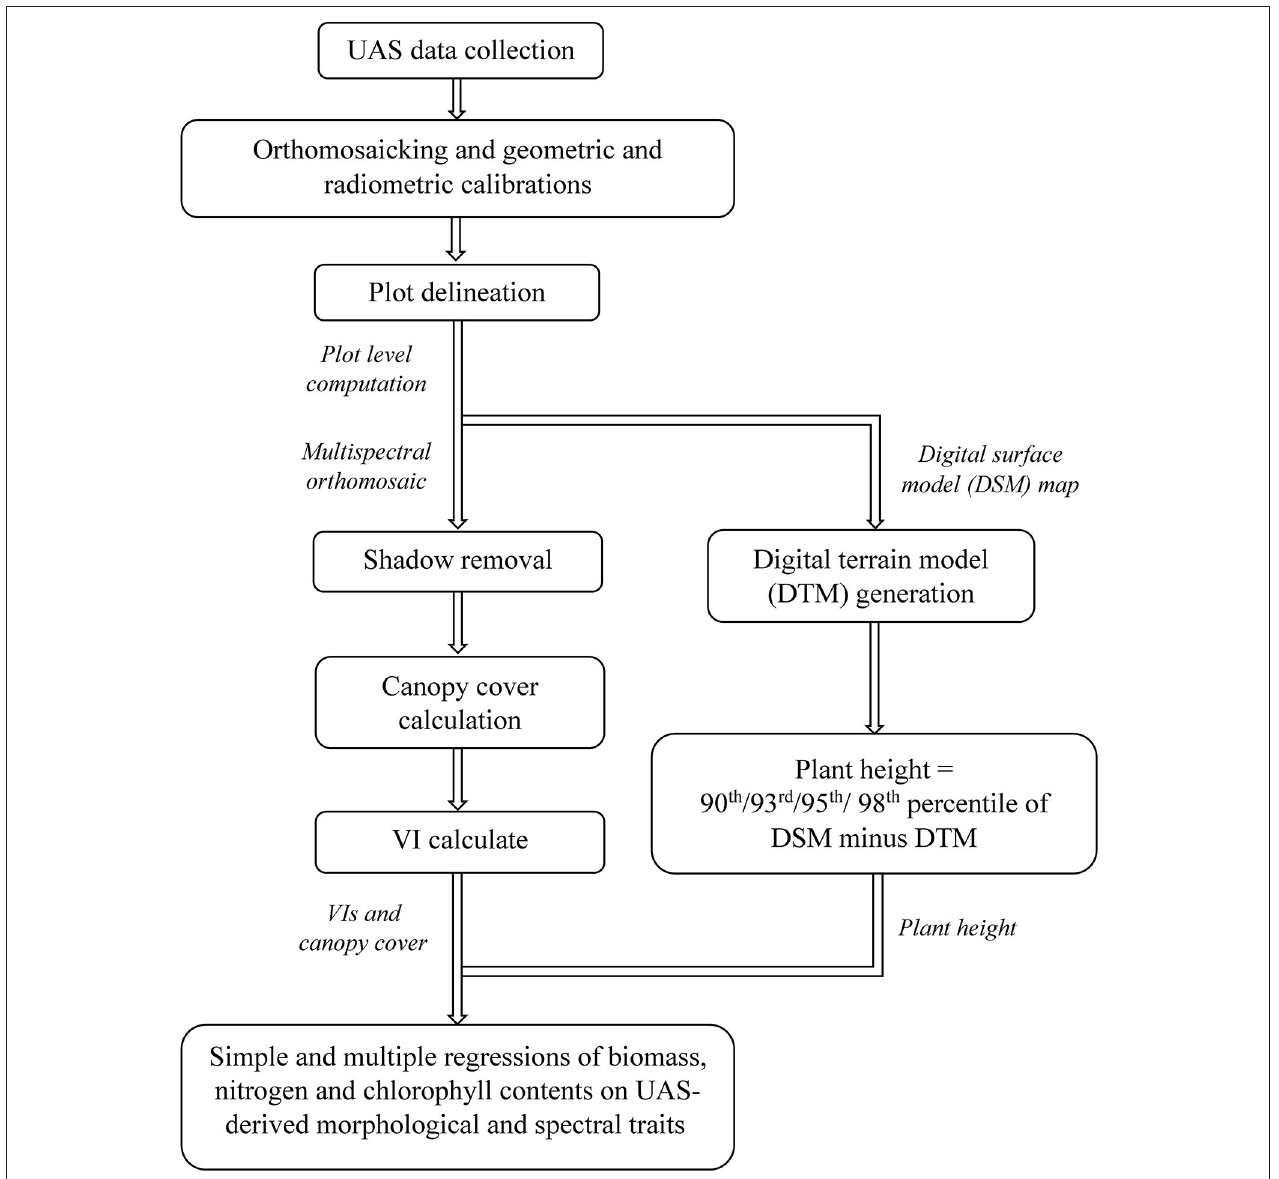
FIGURE 1 | Flowchart of main processing steps in this